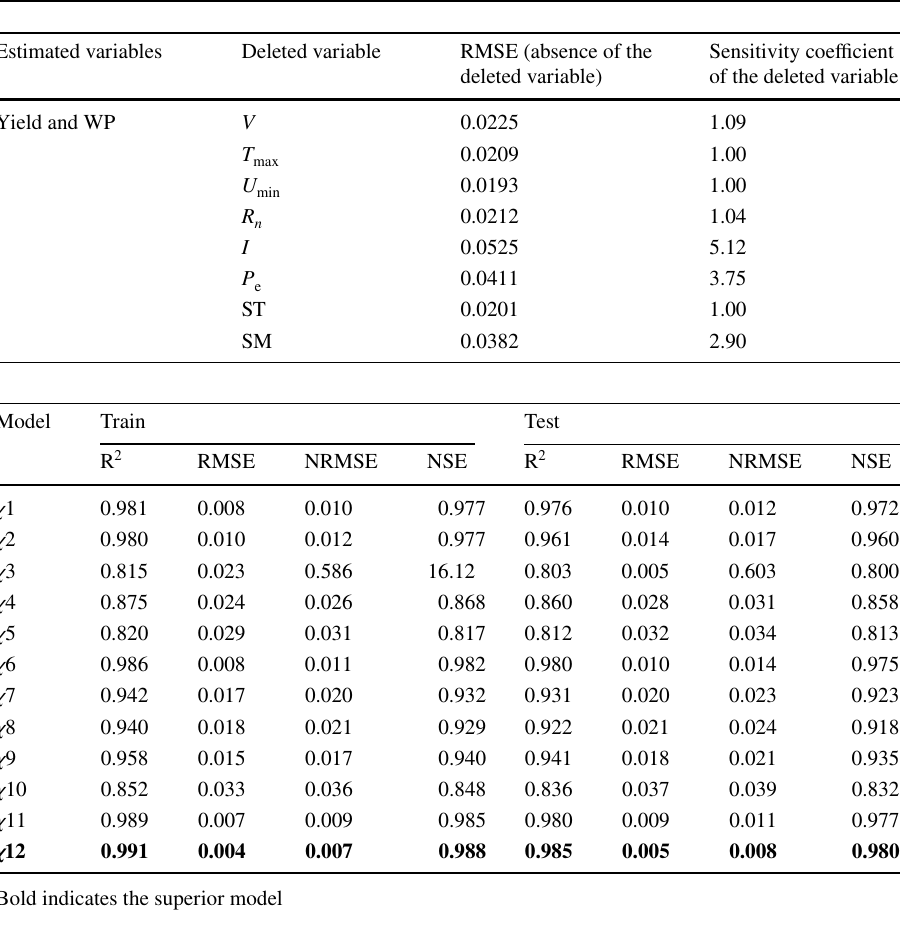
Bold indicates the